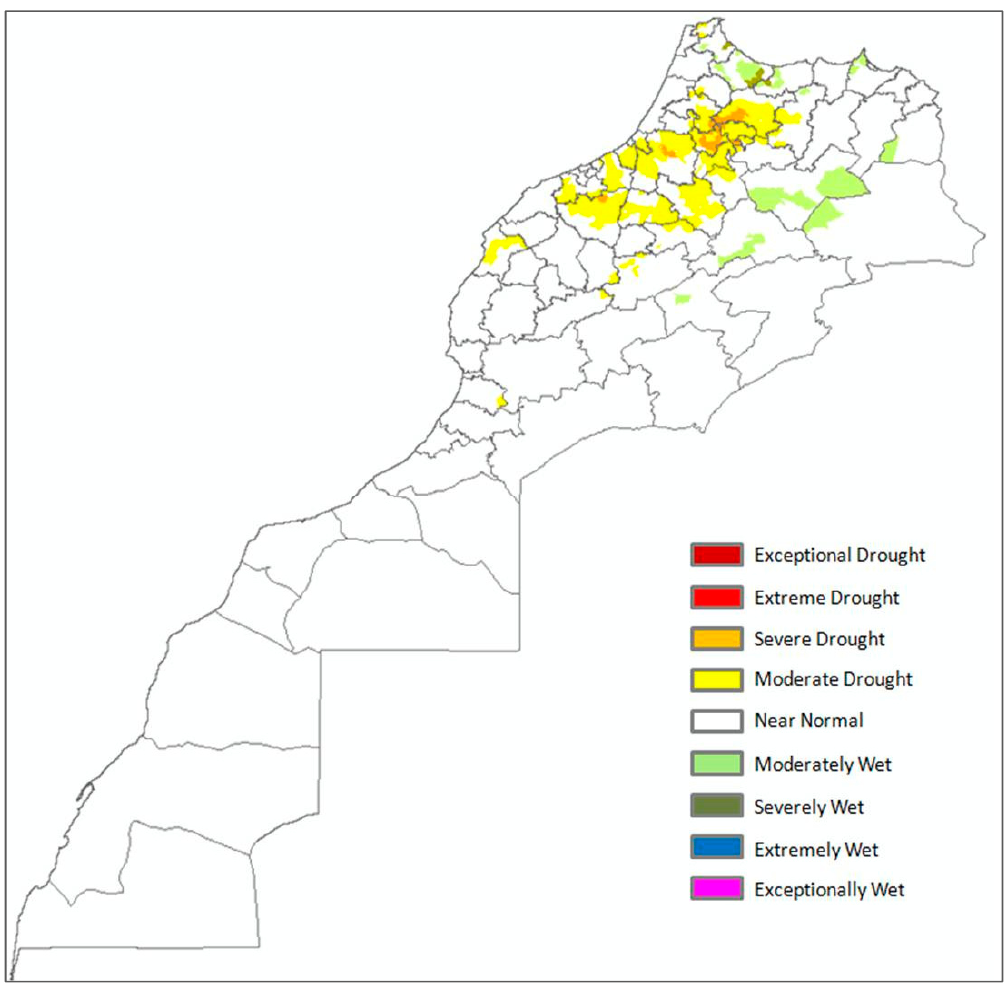
Figure 3. Example of the land surface temperature (LST) day-night difference for February 2016.